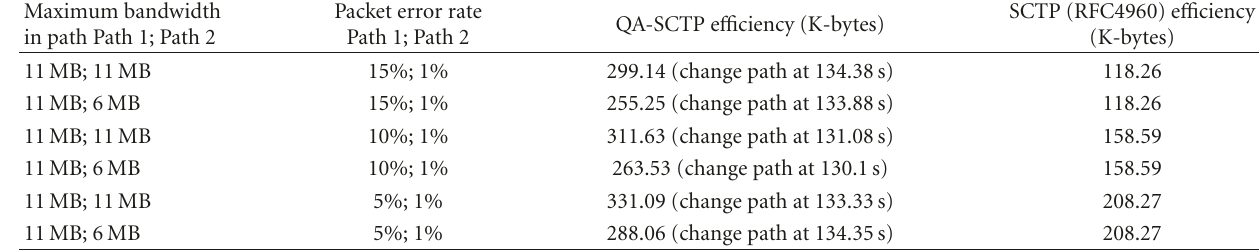
Table 3: QA-SCTP path condition measure/switch experiment results list.